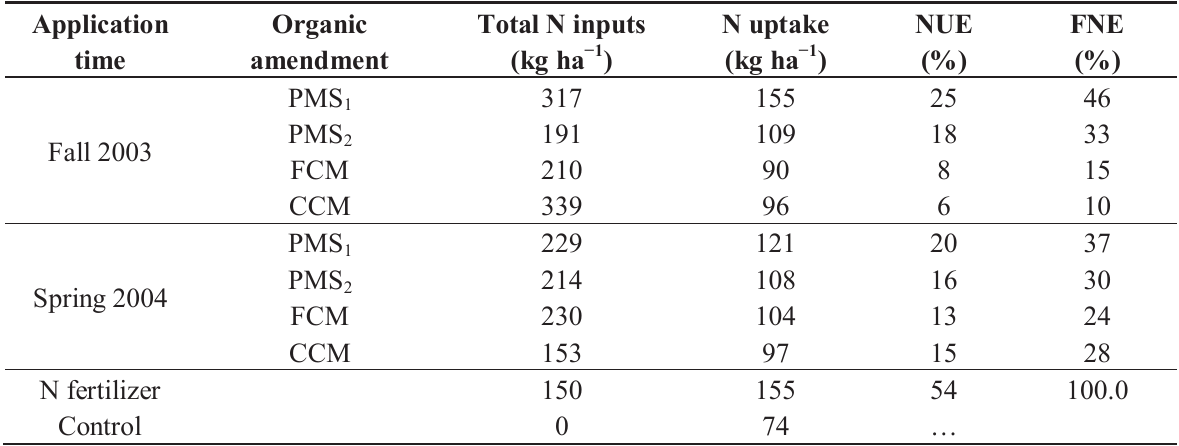
Table 3. Potato N use efficiency and fertilizer N equivalency in the first year of organic amendment application (2004).